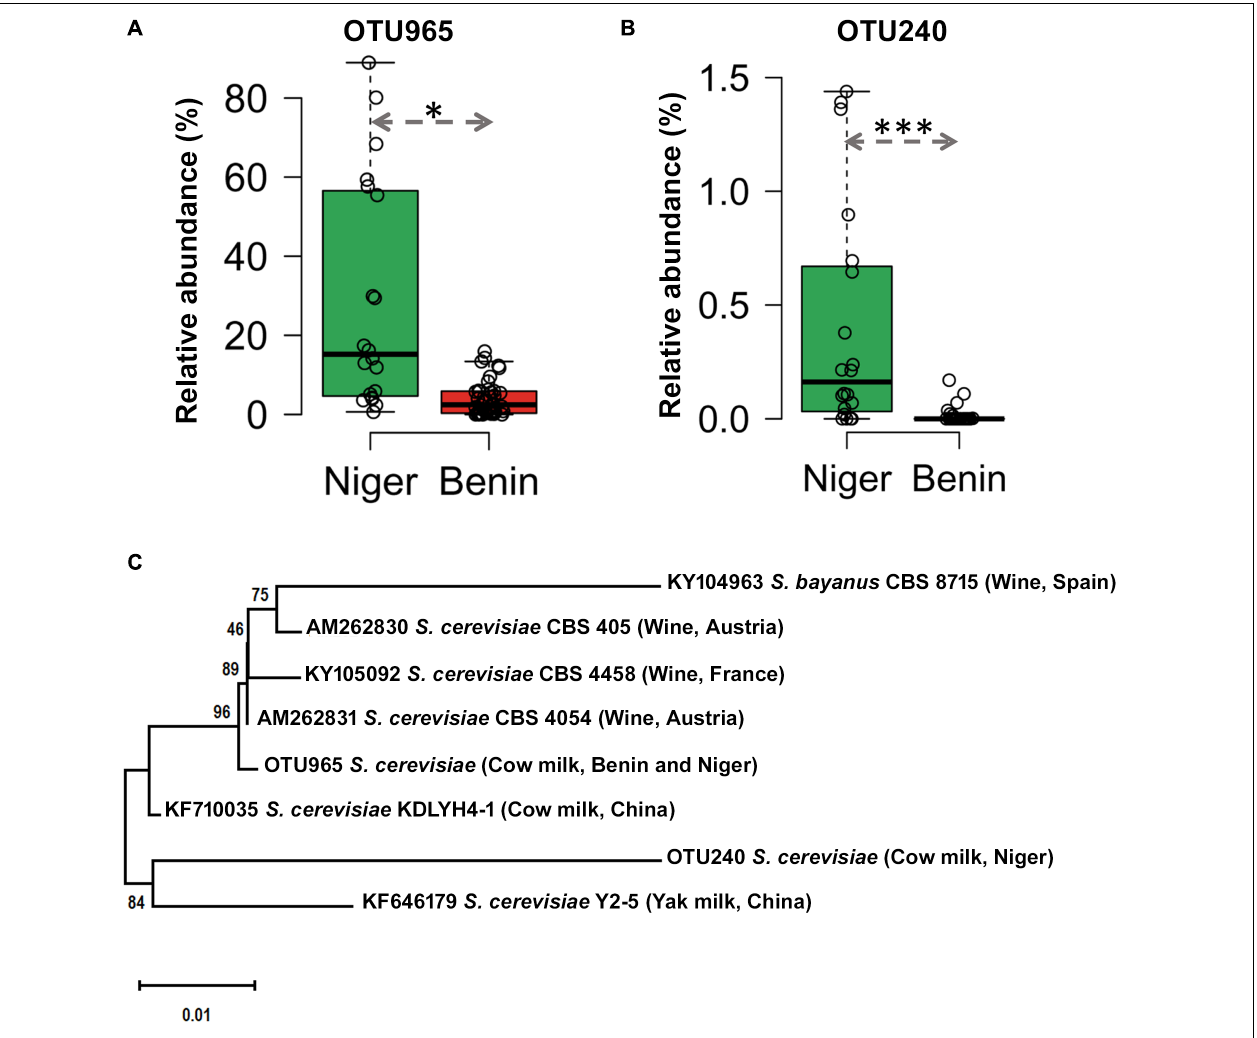
FIGURE 5 | Difference in the occurrence and phylogenetic affiliation of two OTUs of Saccharomyces cerevisiae retrieved from the metagenome of fermented milk products of Niger and Benin. (A,B) Box plots shows the difference in the occurrence of OTU965 and OTU240 in the fermented milk products of Niger and Benin. The significance in difference was calculated by Wilcoxon test with Bonferroni correction and indicated as ∗ q < 0.05, ∗∗∗ q < 0.001. (C) The neighbor-joining phylogenetic tree generated based on the sequences of the internal transcribed spacer (ITS) region of 26S large subunit ribosomal RNA gene of the two OTUs of S. cerevisiae in comparison with the ITS sequence of earlier characterized cultures of S. cerevisiae shows its close relatives of wine and milk origins. Saccharomyces bayanus CBS8715 was maintained as an out-group. The evolutionary distances were computed using the Kimura two-parameter method and the scale indicates the units of the number of base substitutions per